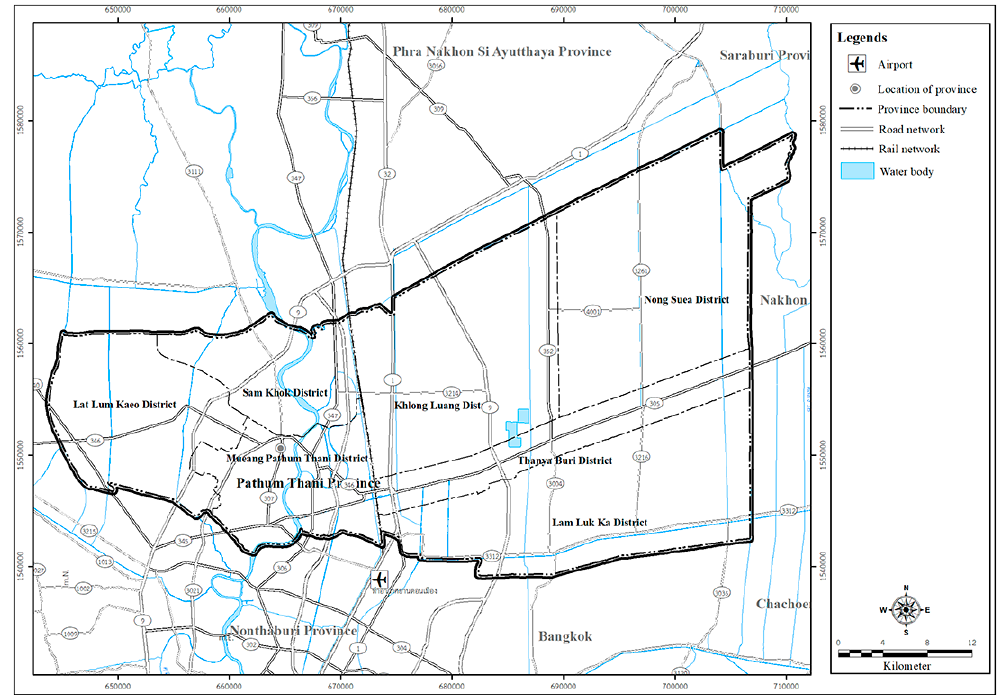
Figure 1. Study area: Pathumthani